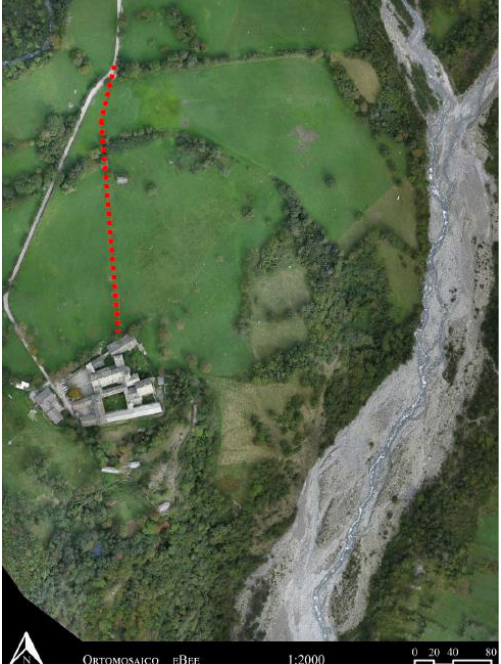
Figure 4. 1:2000 scale orthomap with the ancient access route highlighted in red.